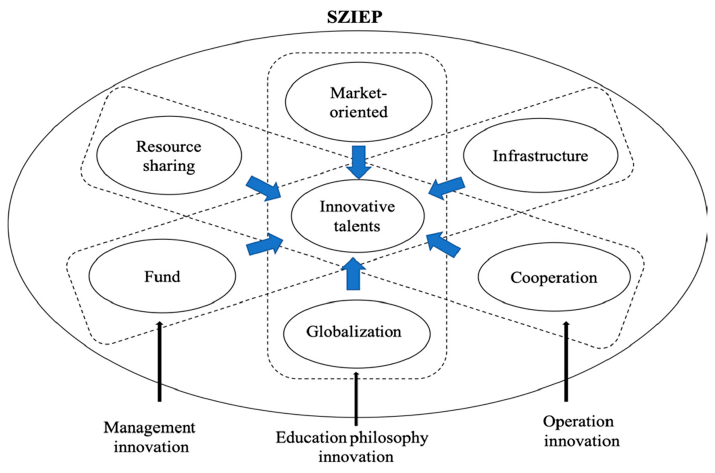
Figure 2. Internal open innovation ecosystem of SZIEP.